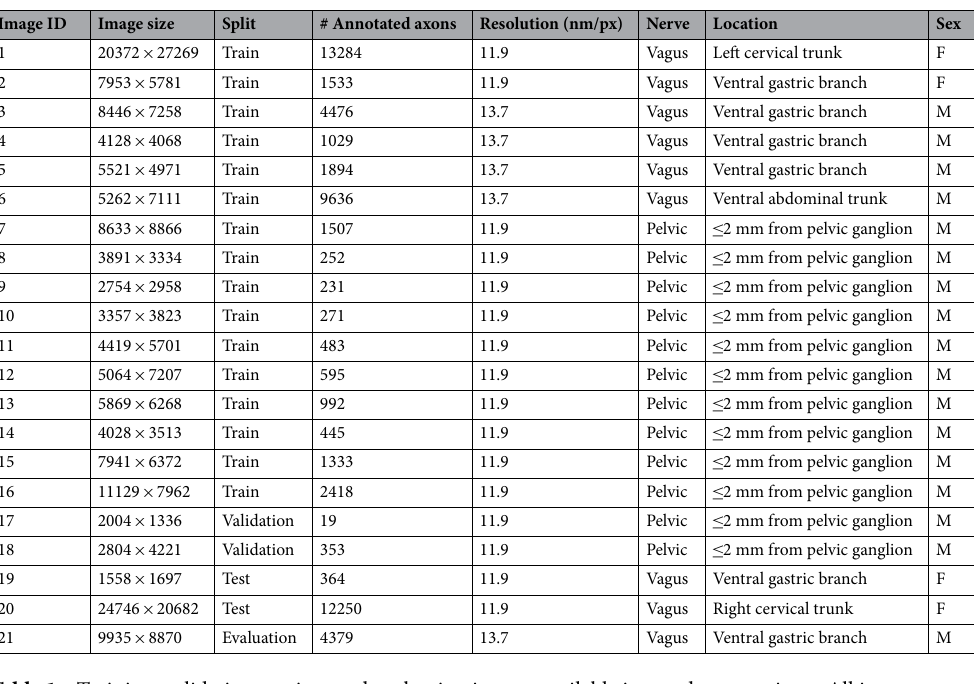
Table 1. Training, validation, testing, and evaluation images available in our data repository. All images are obtained from rats. Training images are used for model training. Validation images are used to optimize model hyperparameters and other training options. Test images are used to evaluate stand-alone segmentation performance. Evaluation image is used to evaluate the algorithm in the expert-in-the-loop setting.